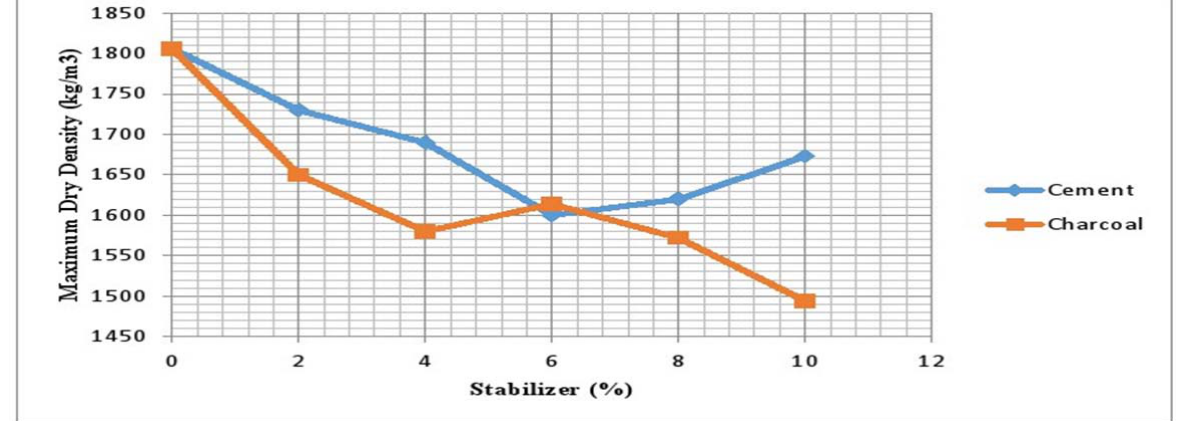
Figure 3. Variation of MDD with percentage of stabilizers.